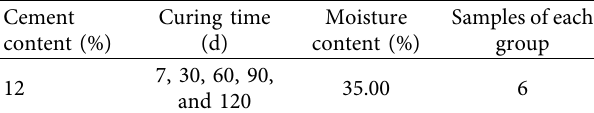
Table 3: The parameters of unconfined compressive test. Cement